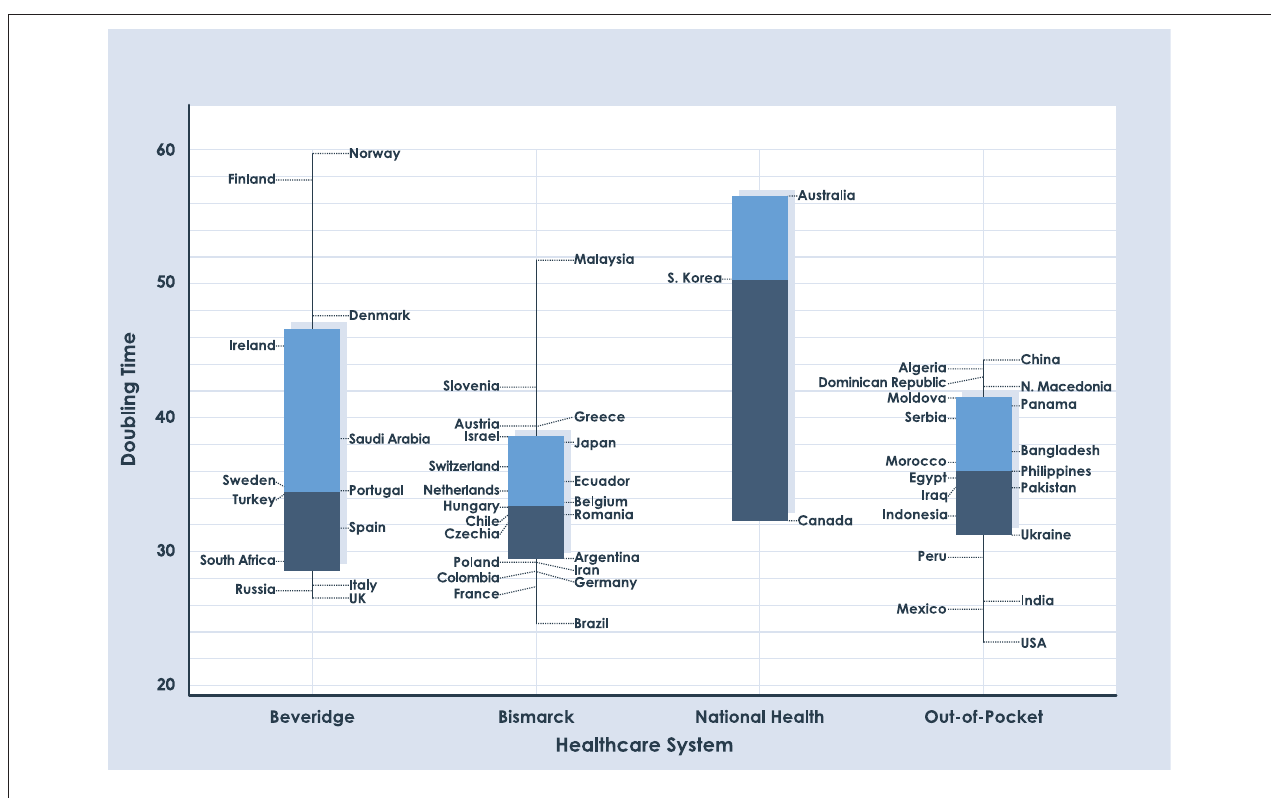
FIGURE 3 | Box plot for DT of deaths with a period length of 360 days.